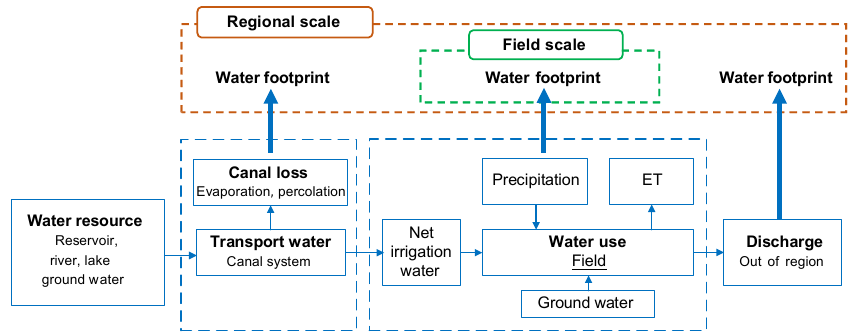
Figure 11. The different scales of calculating water footprint.